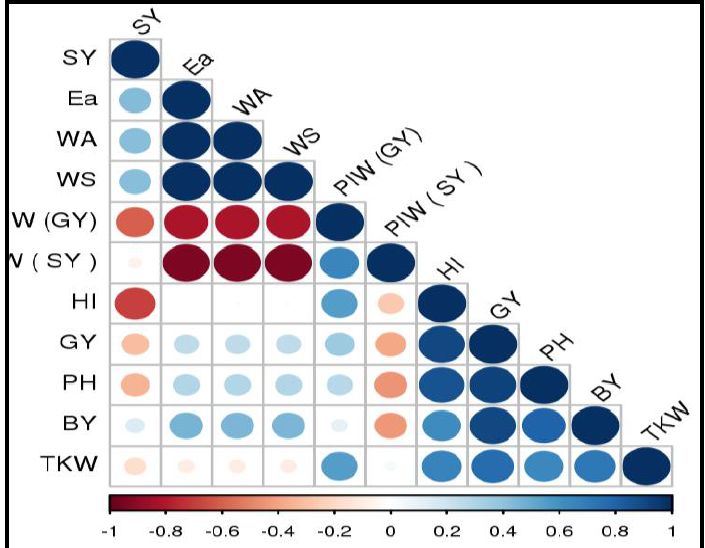
Figure 9. Pearson correlation coefficient heat map among grain yield, agronomical and water relations